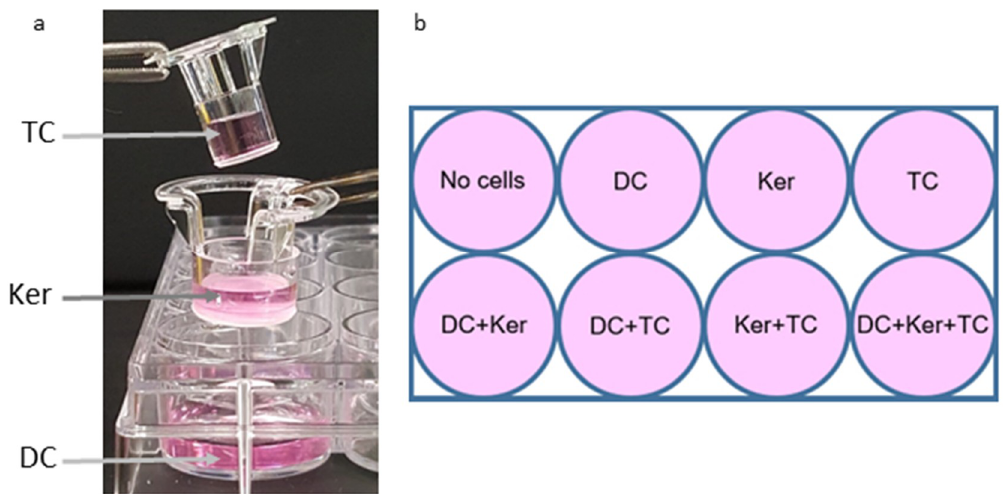
Figure 1. ( a ) Set-up of the three-cell transwell co-culture. The top insert contained CD4+ T-cells (TC), the middle insert contained GE keratinocytes (Ker) and the bottom well contained dendritic cells (DC). Cells were suspended in LGM-3. The inserts stack into each other. A porous membrane is found on the bottom of each insert, allowing small molecules, such as cytokines and MMPs, to travel between the cell layers while cells remain in their designated tiers. This plate was inserted in the incubator on a shaker plate to facilitate diffusion between the inserts. ( b ) Template used to establish the one-cell, two-cell, and three-cell co-cultures. Two plates were constructed; one was treated with HagB (test) and the other with diluent